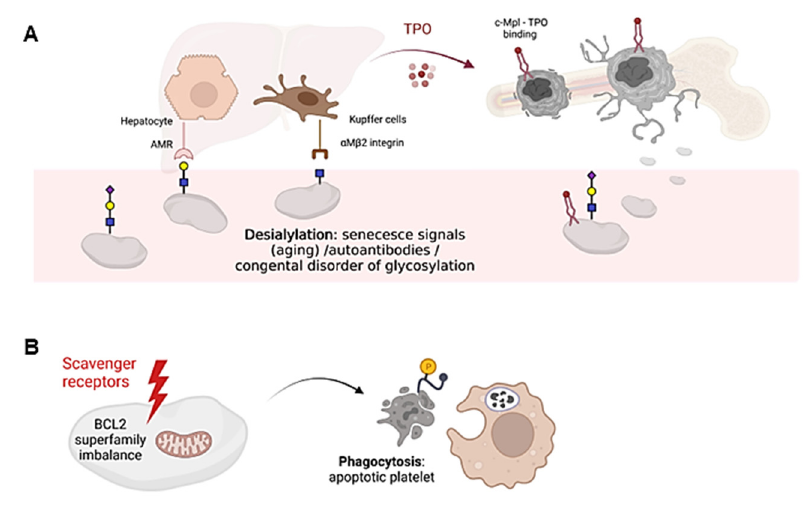
Figure 2. Schematic representation of platelet clearance mechanisms. ( A ) Platelet desialylation can be triggered by senescence signals in “aged” platelets, by the presence of autoantibodies (especially in autoimmune diseases) or by congenital alterations in genes involved in glycosylation. Desialylated platelets are recognized by hepatic AMR to regulate hepatic TPO production and thrombopoiesis, or by Kupffer cells. Bone marrow MKs produce and release young platelets containing sialic acid into the bloodstream. Young platelets maximally internalize TPO through Mpl receptors. ( B ) Platelet survival is regulated by the interaction between pro-survival and pro-apoptotic members of the Bcl-2 family, which are critical regulators of the intrinsic apoptotic pathway. Up-regulation of pro-apoptotic signals mediates platelet clearance through scavenger receptors. Cells undergoing apoptosis modify the redistribution of phosphatidylserine (PS, yellow circle) from the inner to the outer lamella of the plasma membrane, which serves as a molecular signal for clearance by phagocytes. The figure was created Biorender.com (accessed on 13 February